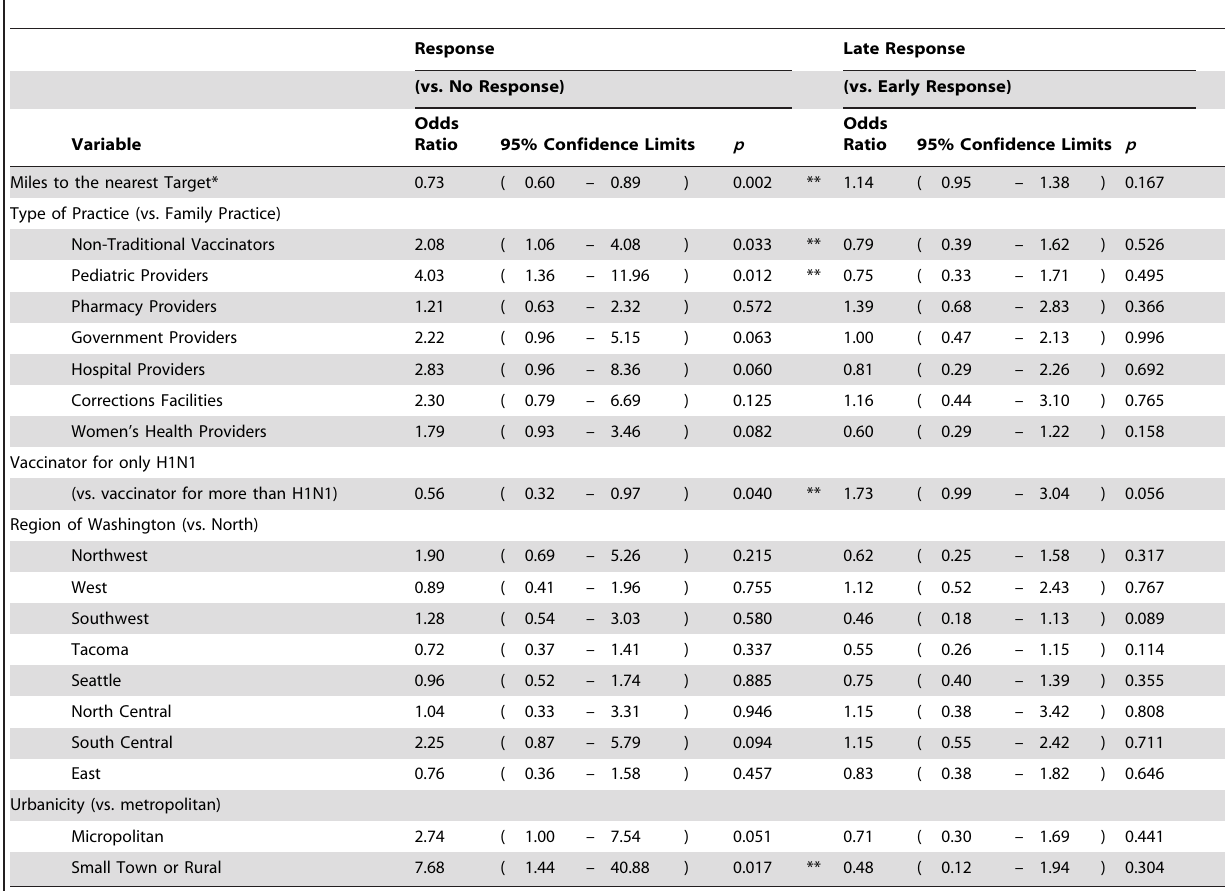
Table 2. Logistic Regression: Association between response and timing of response with geographic and demographic variables.